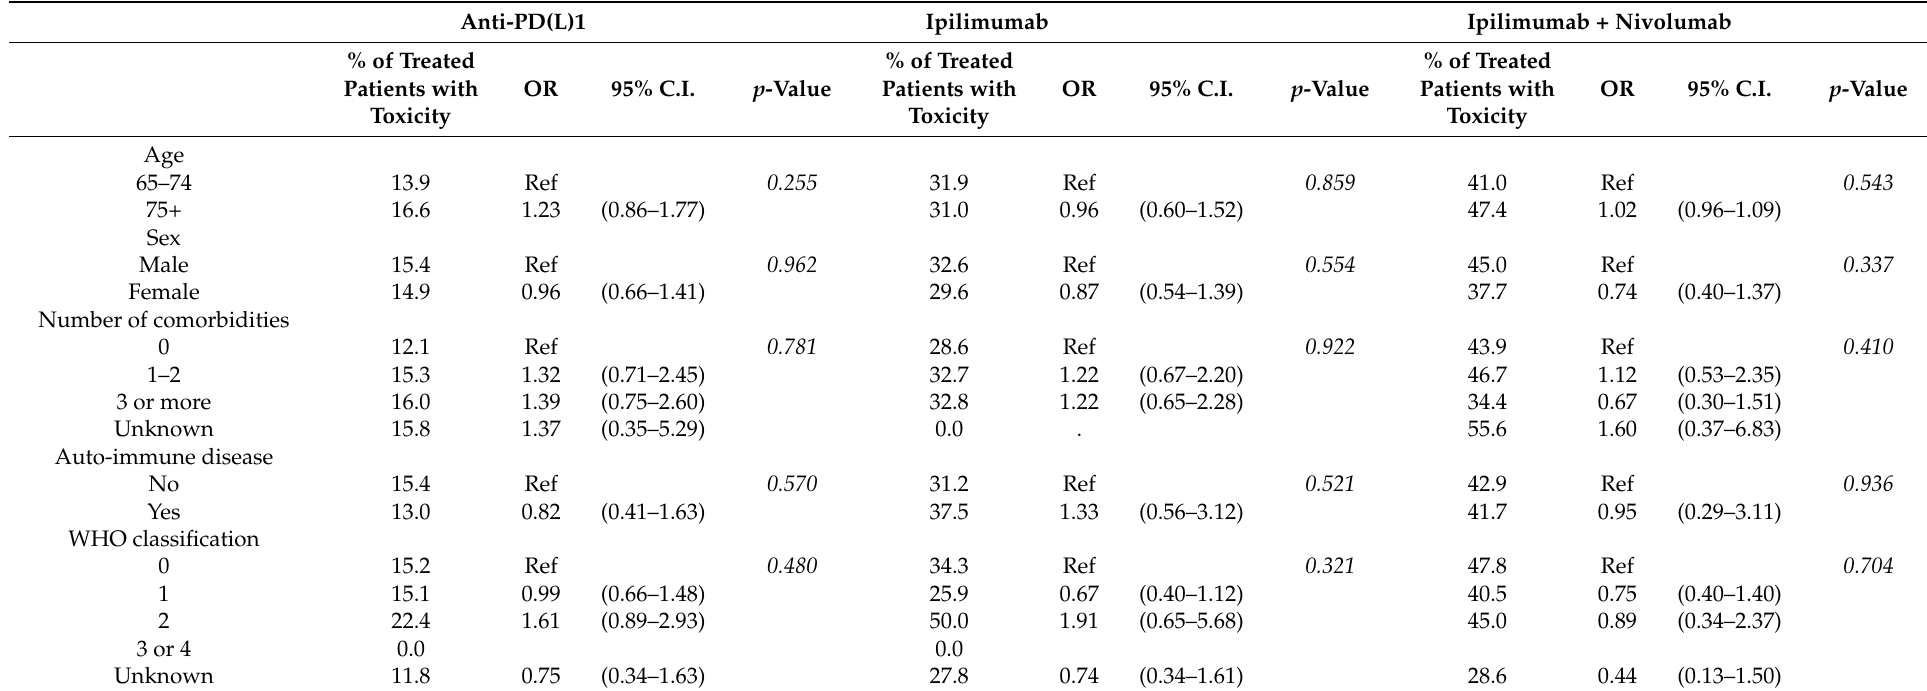
Table 2. Determinants of grade ≥ 3 immunotherapy